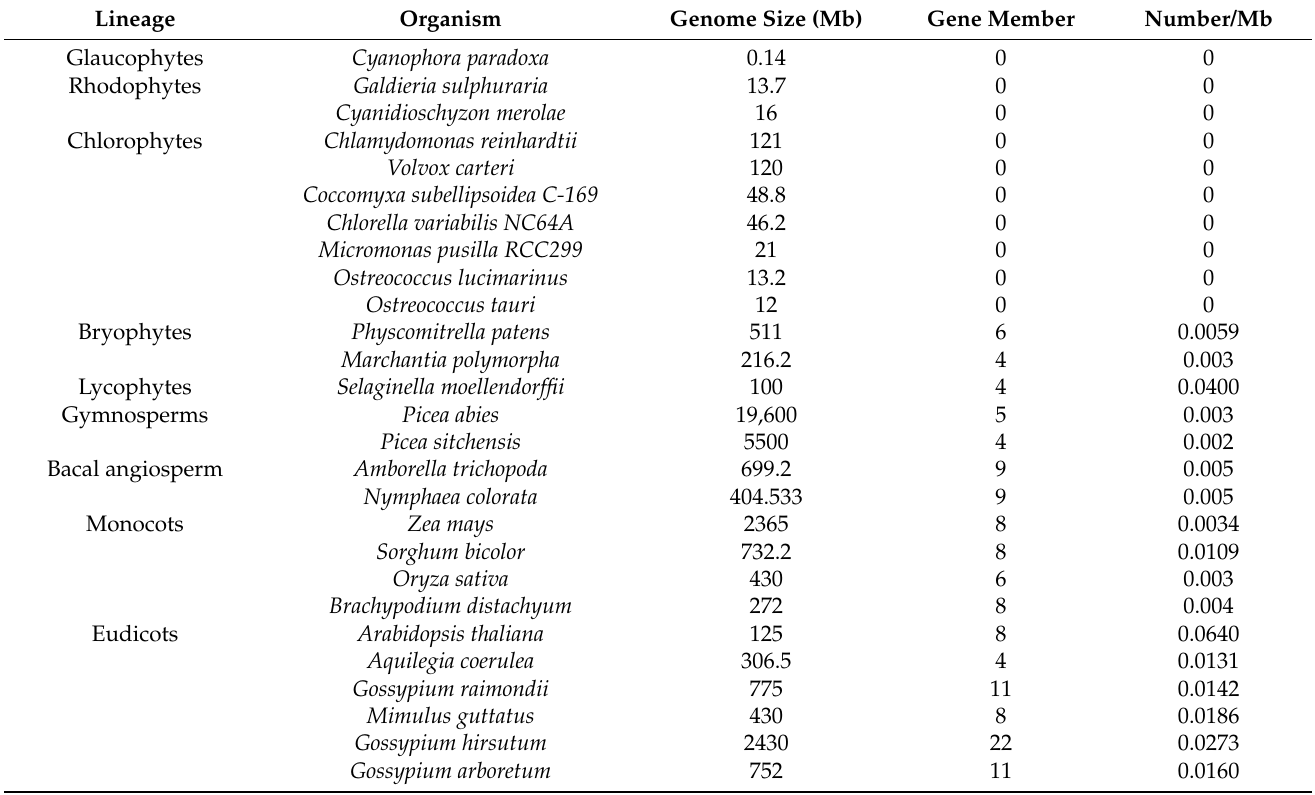
Table 1. Summary of the BES1 transcription factors of representative plant